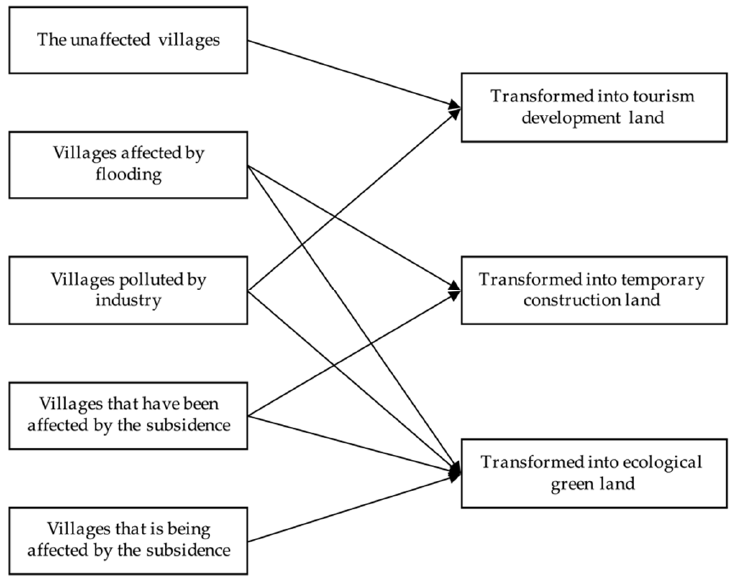
Figure 9. Land use pattern in coal mining subsidence area. Source: “Conceptual Planning for Ecological Governance of Coal Mining Subsidence Area in Western Huainan City”.